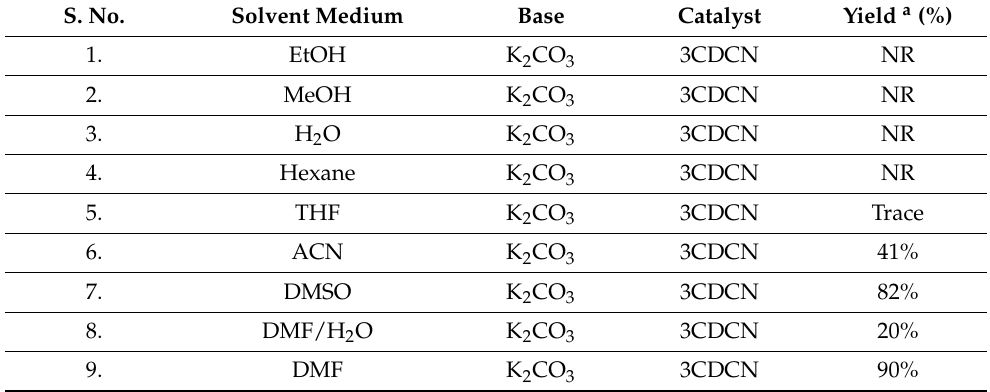
Table 3. Optimization of